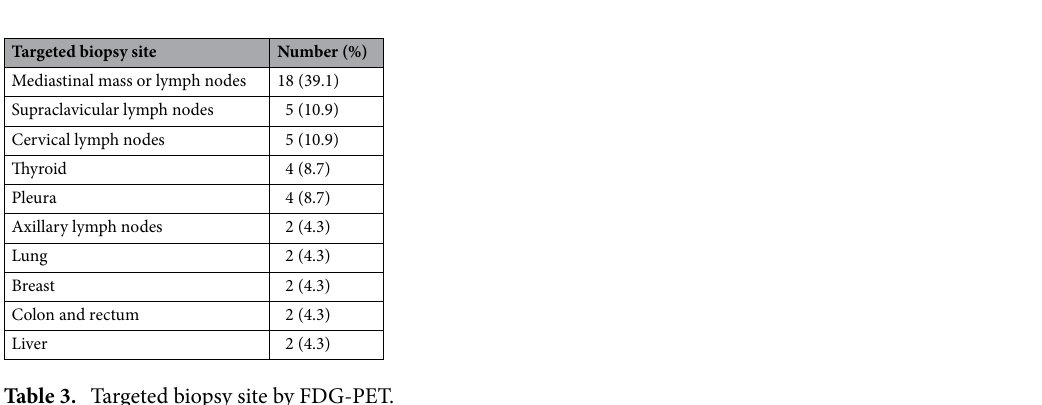
Table 3. Targeted biopsy site by FDG-PET.